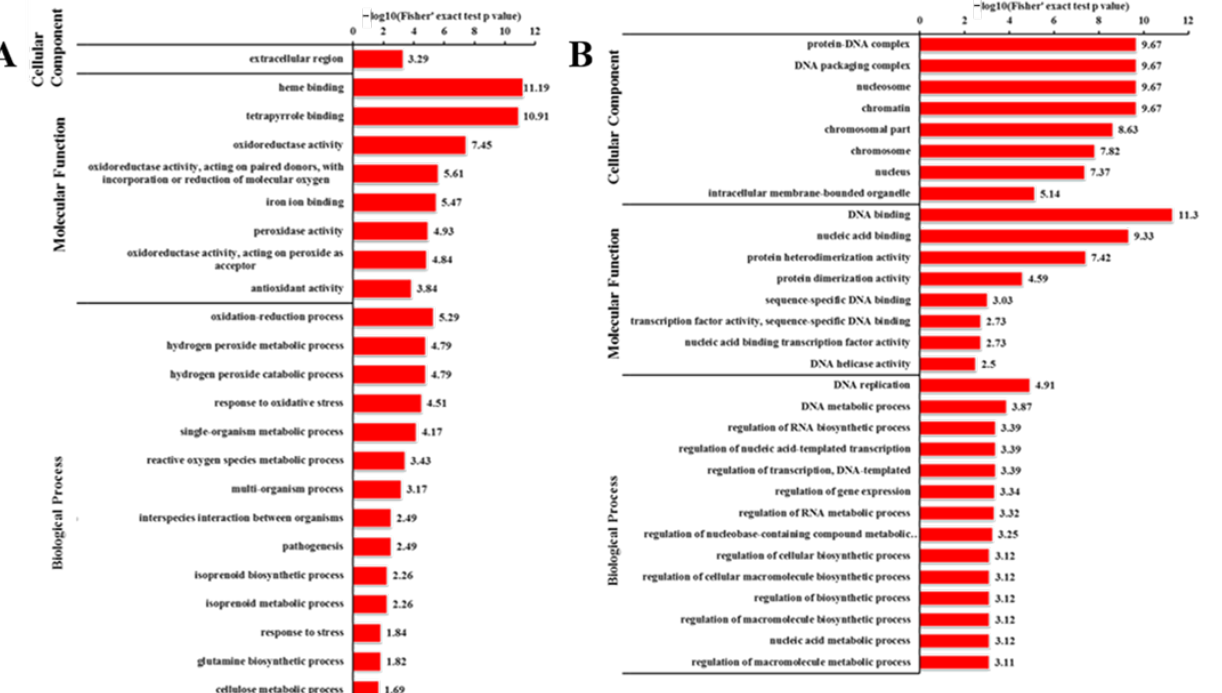
Figure 15. GO enrichment analysis of DEPs. ( A ) GO enrichment analysis of significantly up-regulated proteins. ( B ) GO enrichment analysis of significantly down-regulated proteins.